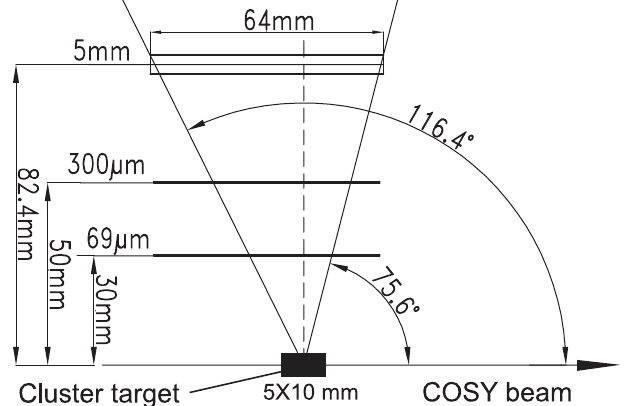
FIG. 4. Top view of the STT, consisting of three layers of different thickness. The approximate extension of the cluster target beam in the x - z plane is indicated, along with the approxi- mate polar angles